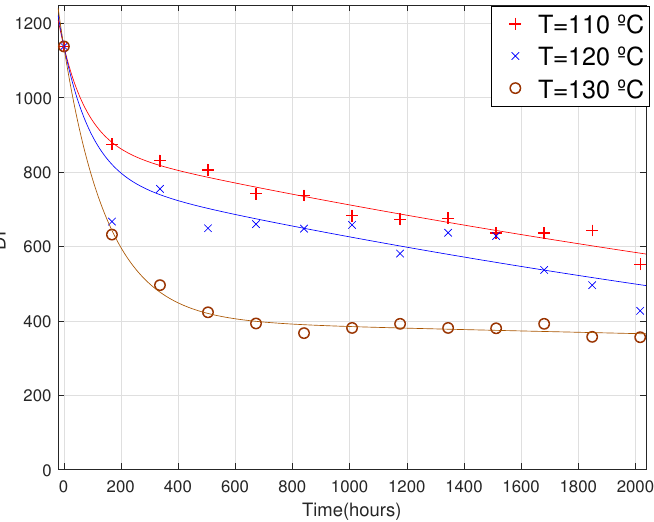
Figure 4. DP evolution vs. aging time of paper impregnated with NE. Taken from